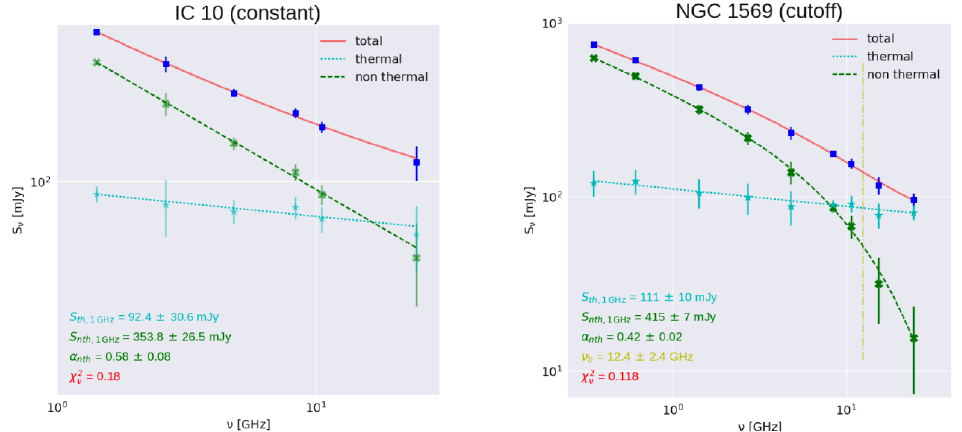
Figure 5. Global radio continuum spectra from IC10 and NGC1569, obtained by the Effelsberg 100 m telescope [85]. Measured flux densities: blue squares connected by a red solid line; free-free emission: cyan stars connected by a cyan dotted straight line; non-thermal emission: green crosses connected by a green dashed line. Characteristic parameters are plotted in the lower left, indicating the thermal and non-thermal contributions at 1GHz. The vertical yellow dash-dotted line in the right panel denotes the break frequency (12.4GHz), which is also given in the lower left of this panel. The nonthermal spectral indices at 1GHz and the reduced χ 2 values of the fits are presented in the lower left corners of both